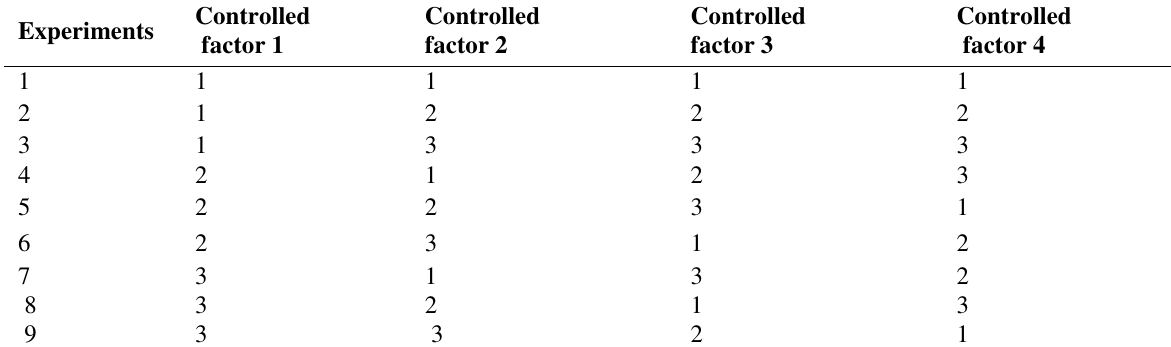
Taguchi orthogonal array for melting process L9